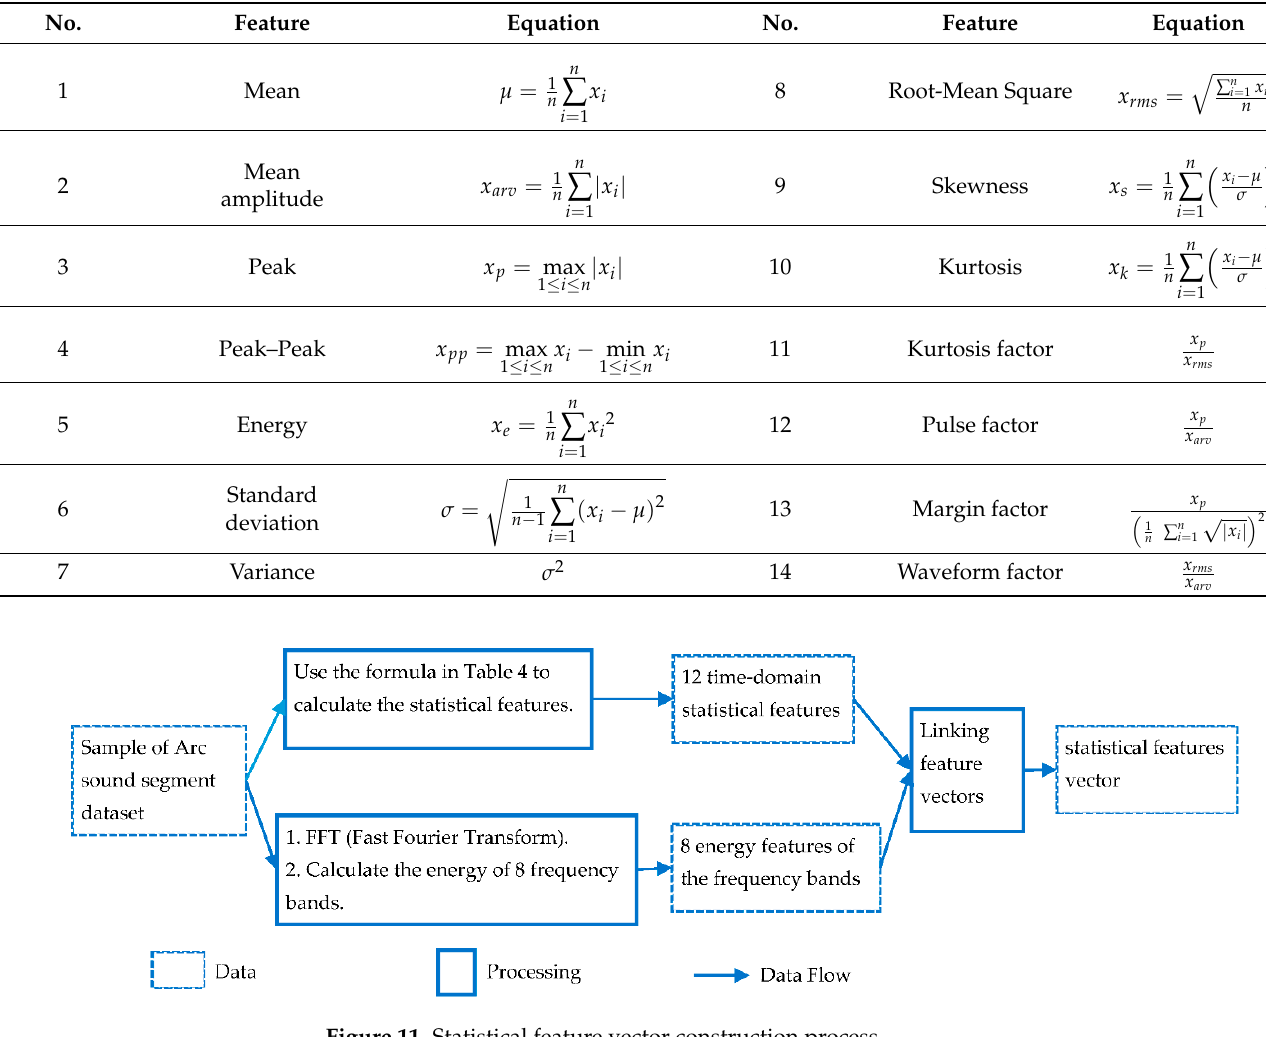
Figure 11. Statistical feature vector construction process. Table 4. Time domain statistical features equations.